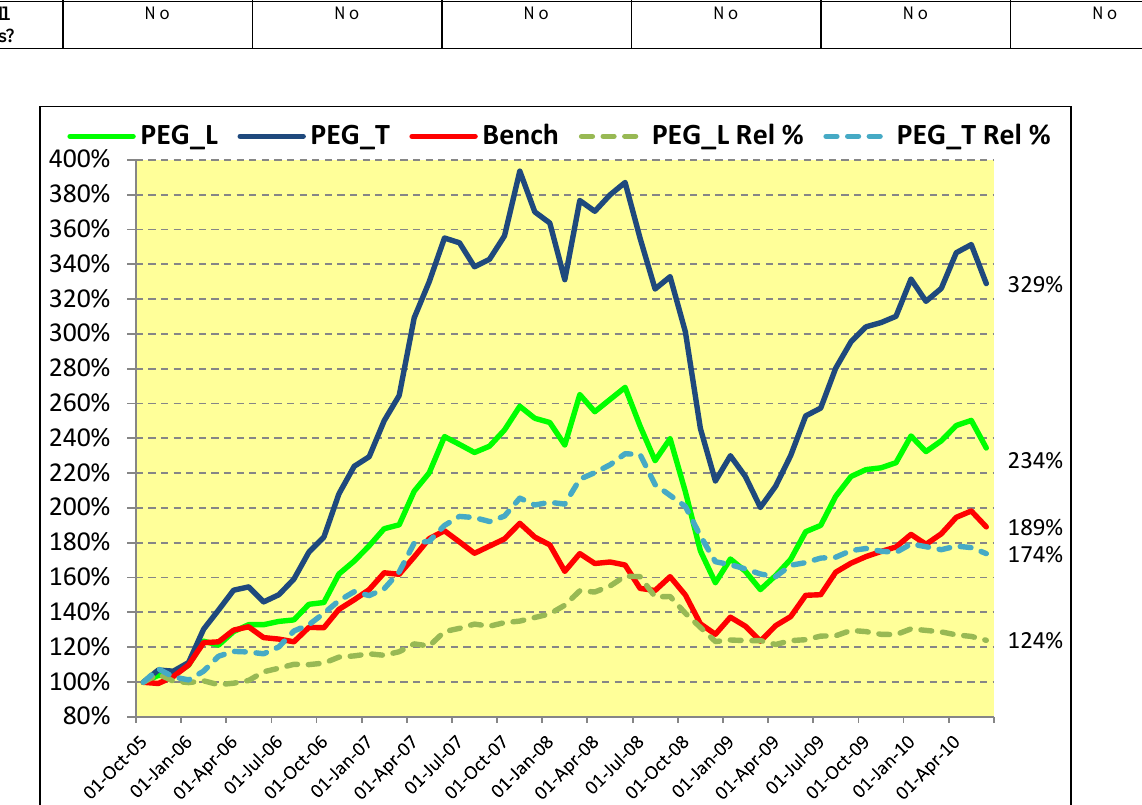
Figure 3: Comparison of optimal PEG trading rule